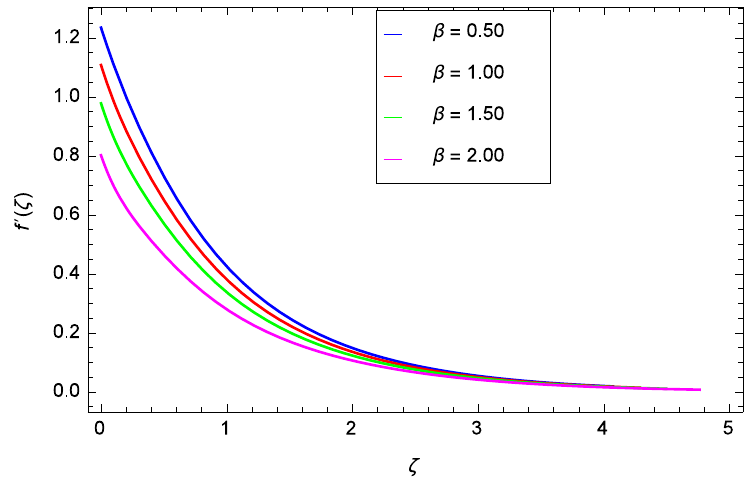
Figure 2. Influence of β on f (cid:48) ( ζ )